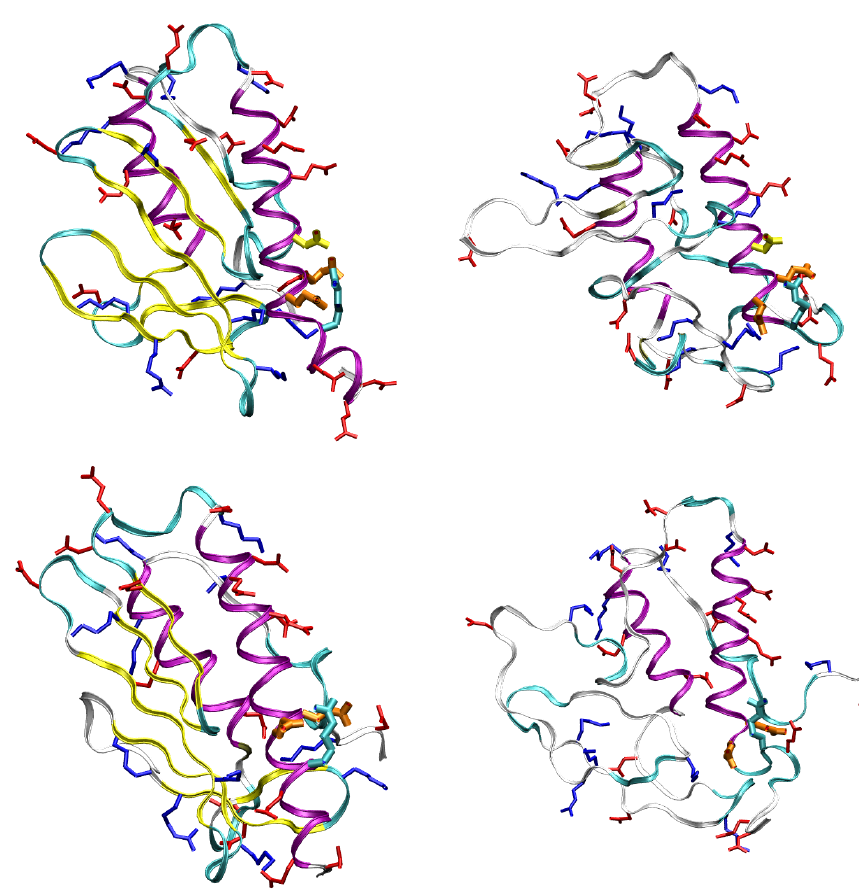
Figure 8. Configurations representing folded (left) and unfolded (right) states for WT (top) and D104G (bottom) sequences. Glu 100-101 are represented as orange sticks; Asp 104 (only in WT) is in yellow; Arg 97 is cyano; all other Arg/Lys sidechains are in blue; Asp and Glu sidechains are red. Structural parameters (see also Table 2) are: top-left: S β ,1–4 = 14, d 1 < 5 Å, d 2 < 10 Å, β 1,2 = 5 ◦ , RMSD1 = 2.7 Å, RMSD2 = 4.3 Å; top-right: S β ,1–4 = 4, 5 < d 1 < 10 Å, 10 < d 2 < 20 Å, β 1,2 = 30 ◦ , RMSD1 = 8.4 Å, RMSD2 = 7.5 Å; bottom-left: S β ,1–4 = 14, d 1 < 5 Å, 10 < d 2 < 20 Å, β 1,2 = 21 ◦ , RMSD1 = 1.6 Å, RMSD2 = 5.0; bottom-right: S β ,1–4 = 4, 7.5 < d 1 < 12.5 Å, 10 < d 2 < 20 Å, β 1,2 = 39 ◦ , RMSD1 = 6.6 Å, RMSD2 = 6.3 Å. d 1 is the distance analyzed in Figure 9; β 1,2 is the angle analyzed in Figure 10; d 2 is the distance analyzed in Figure